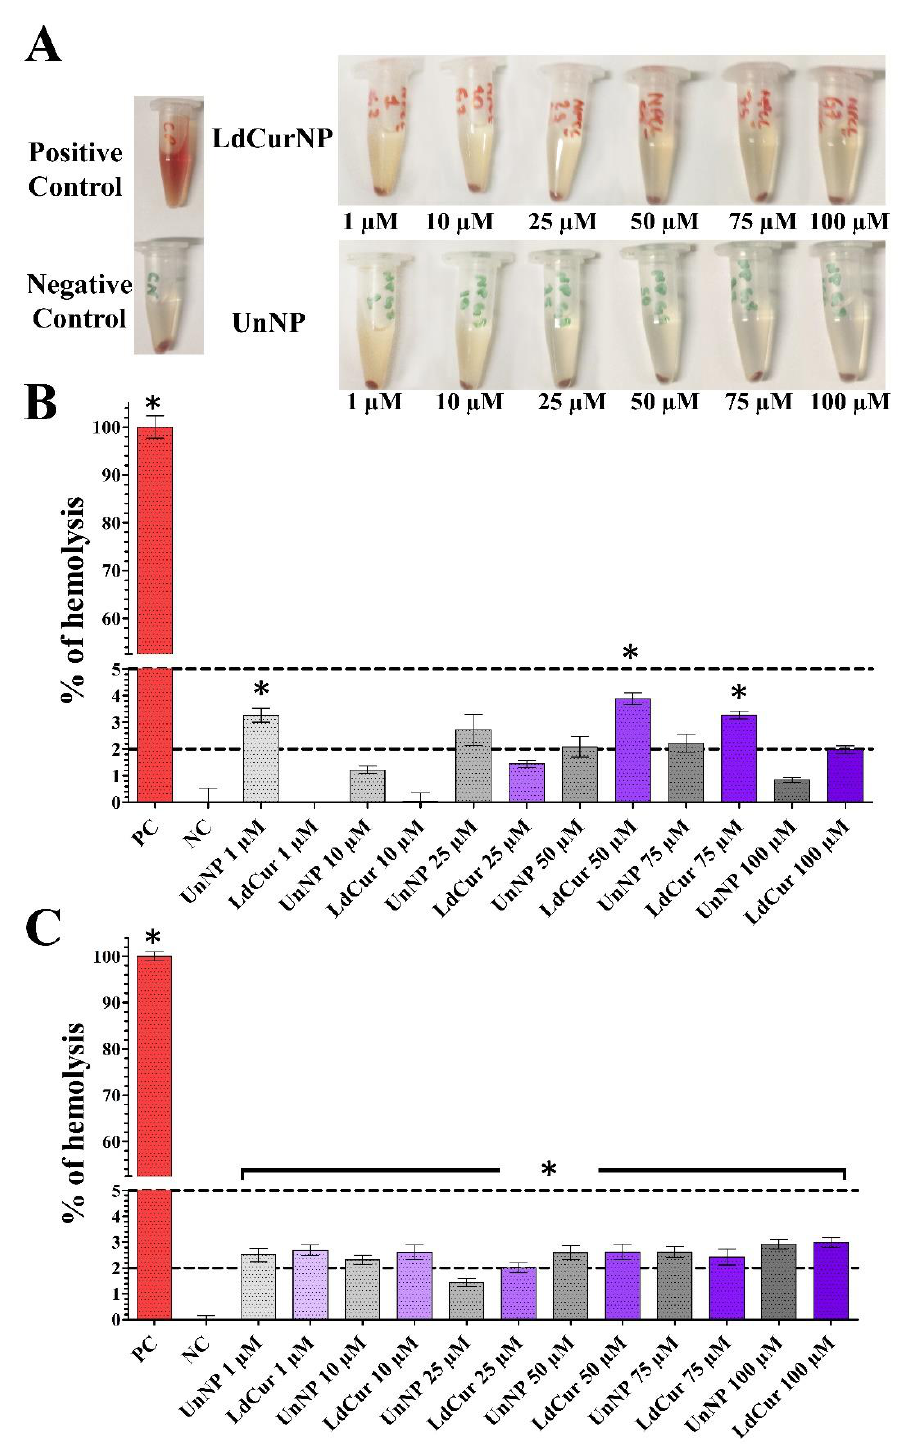
Figure 5. ( A ) Hemolysis assay microtubes after incubation with nanoparticles suspensions in different concentrations (1, 10, 25, 50, 75 and 100 µM) for 1 hour and centrifugation at 1500 G for 5 min. PC (Positive Control, distilled water), NC (Negative Control, saline), UnNPs (Unloaded Nanoparticles), LdCurNPs (L-DOPA and Curcumin- Loaded Nanoparticles). ( B , C ) The results are mean ± standard error of the hemolysis rate of samples 1 and 2, respectively. Dotted lines are the thresholds of 5% (slightly hemolytic) and 2% (non-hemolytic) hemolysis rate and * p < 0.05; n.s. p > 0.05 when compared with the negative